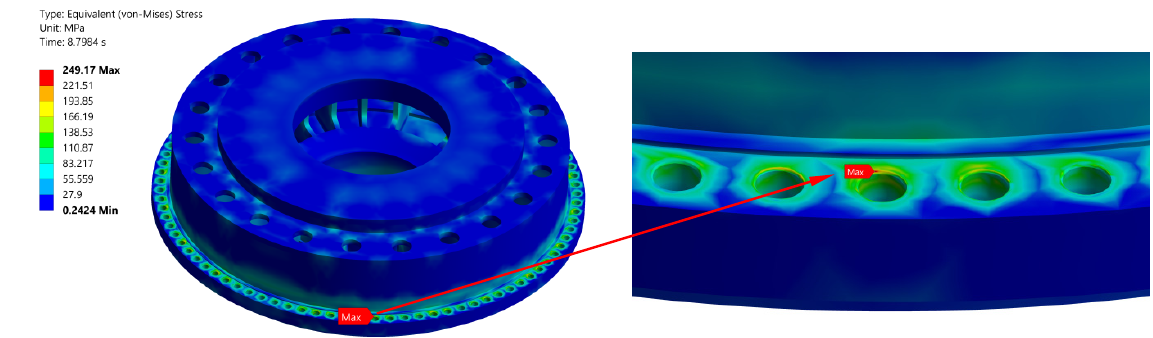
Figure 18. Von Mises stress distribution of the head-cover.